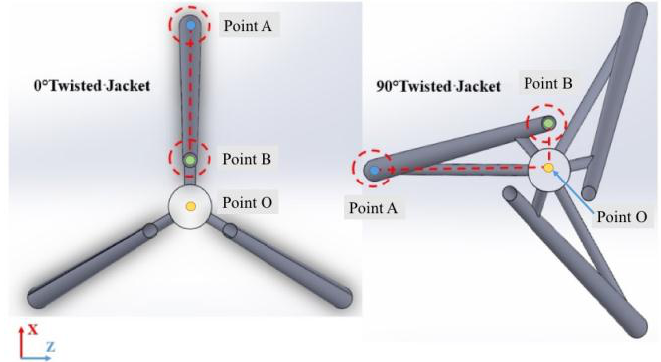
Figure A3. Terminology of the structural members of a TJ-structure.